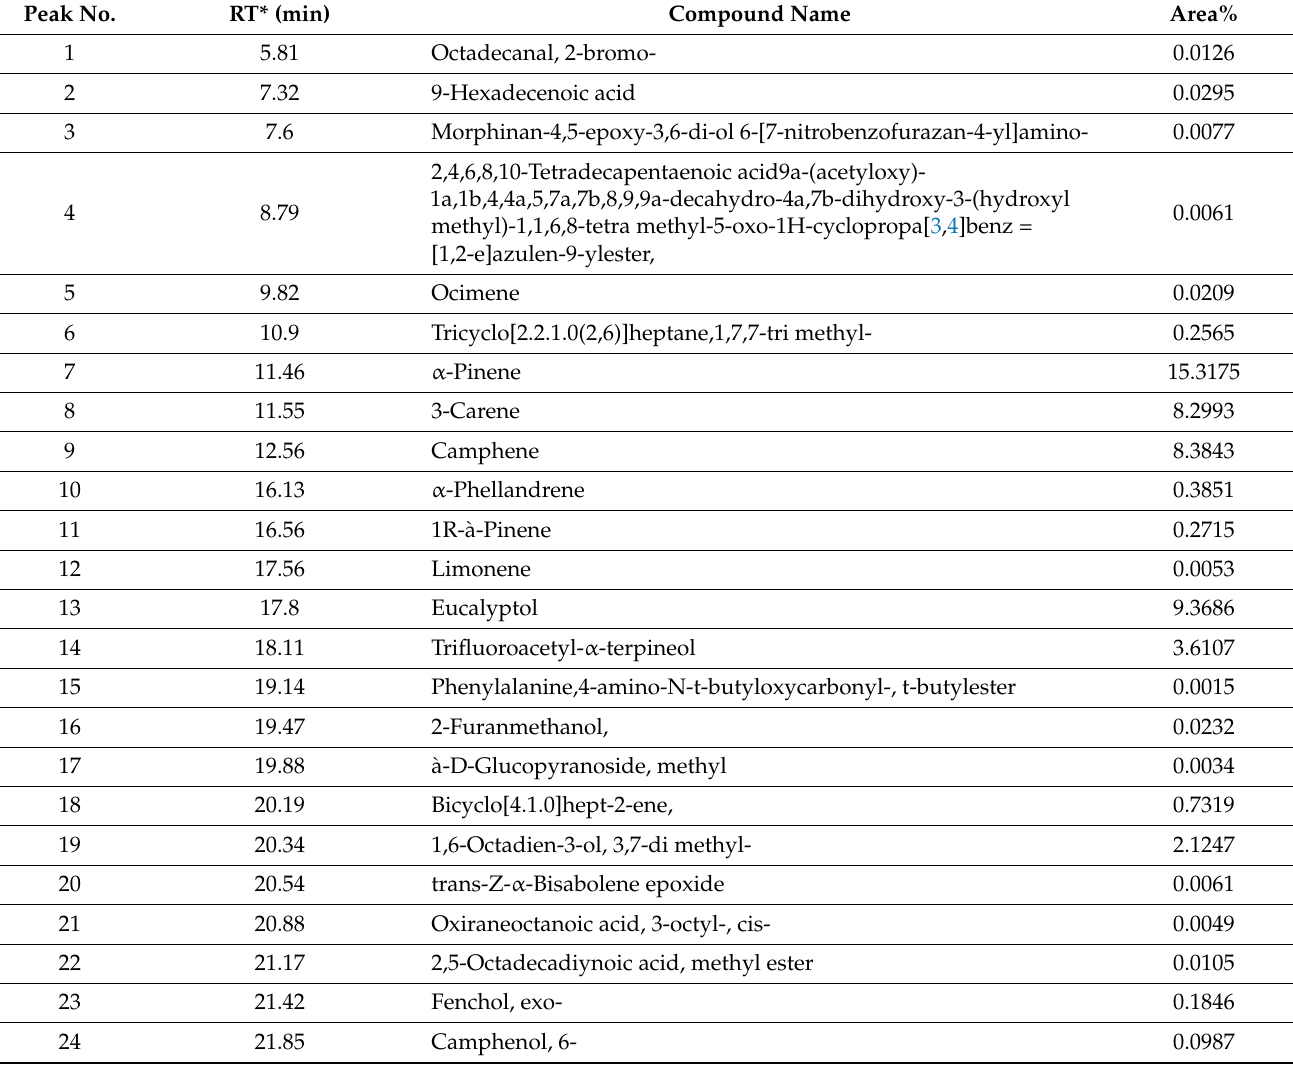
Table 1. Gas chromatography-Mass Spectrometry (GC-MS) analysis results of REO. Peak